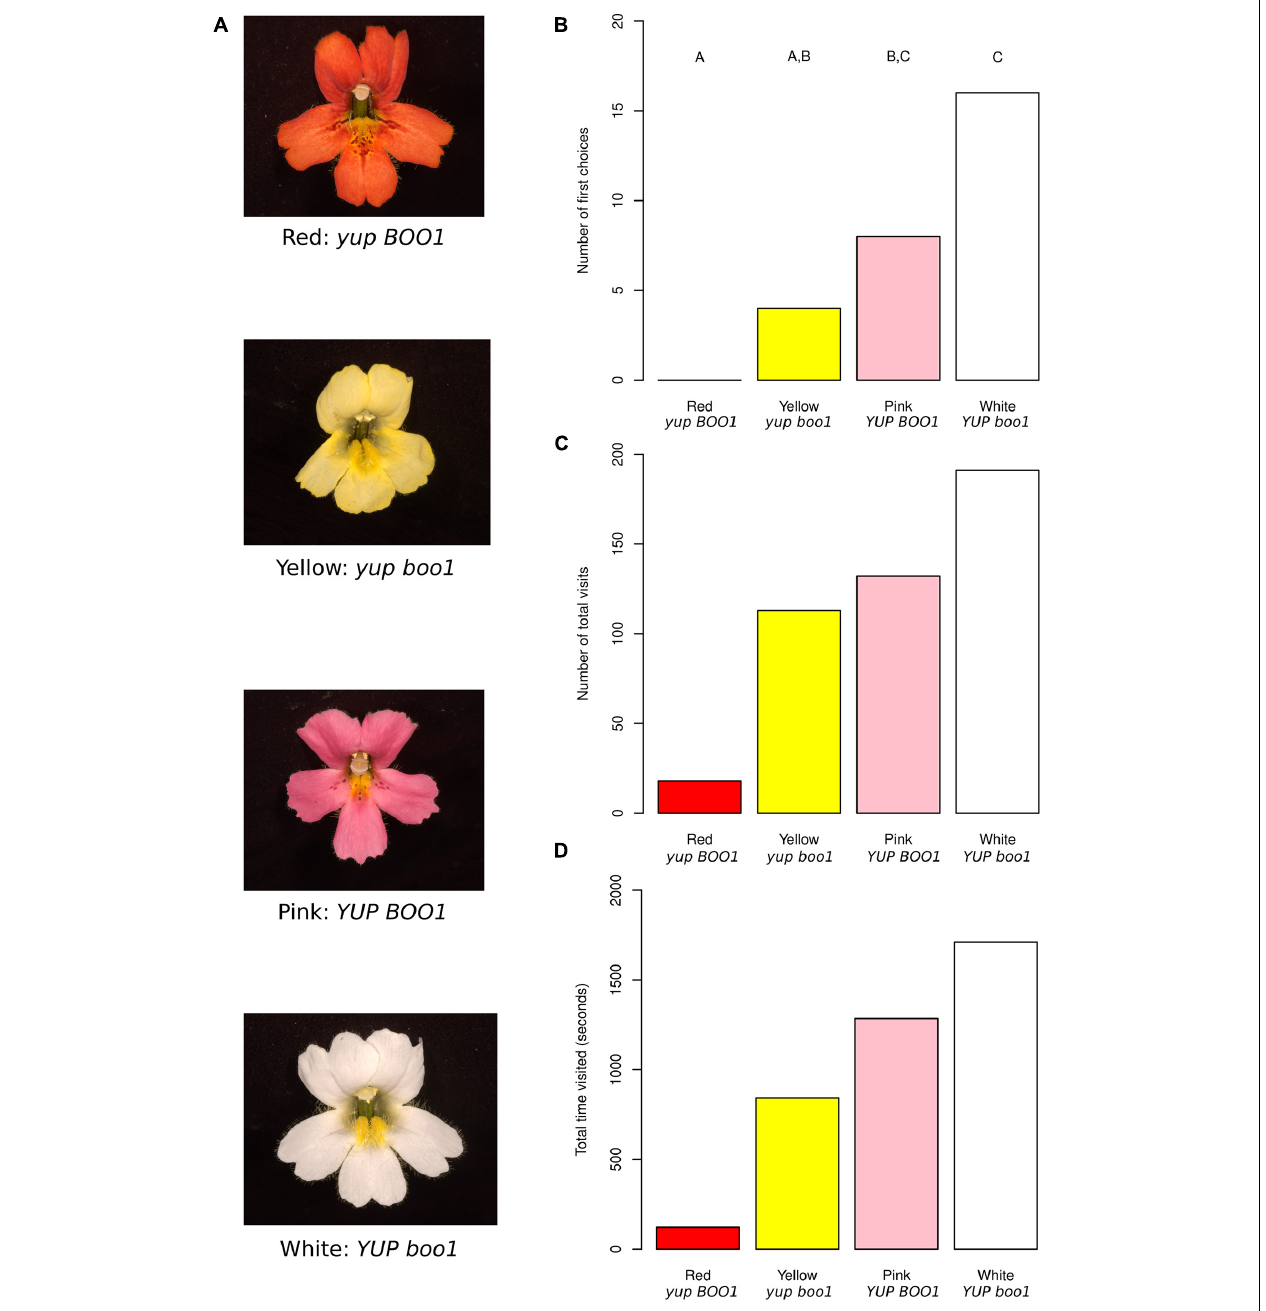
FIGURE 1 | Mimulus color mutants and behavioral results. (A) Red, yellow, pink, and white Mimulus flowers from a single F 2 population with their inferred genotypes. (B) First choices to the flowers across all moths, with letters indicating statistically significant differences between colors. (C) Total visits to the flowers across all moths. (D) Total time each flower color was visited across all moths. Data from individual moths were not pooled for statistics for (C,D) and therefore no statistical differences are shown (see section